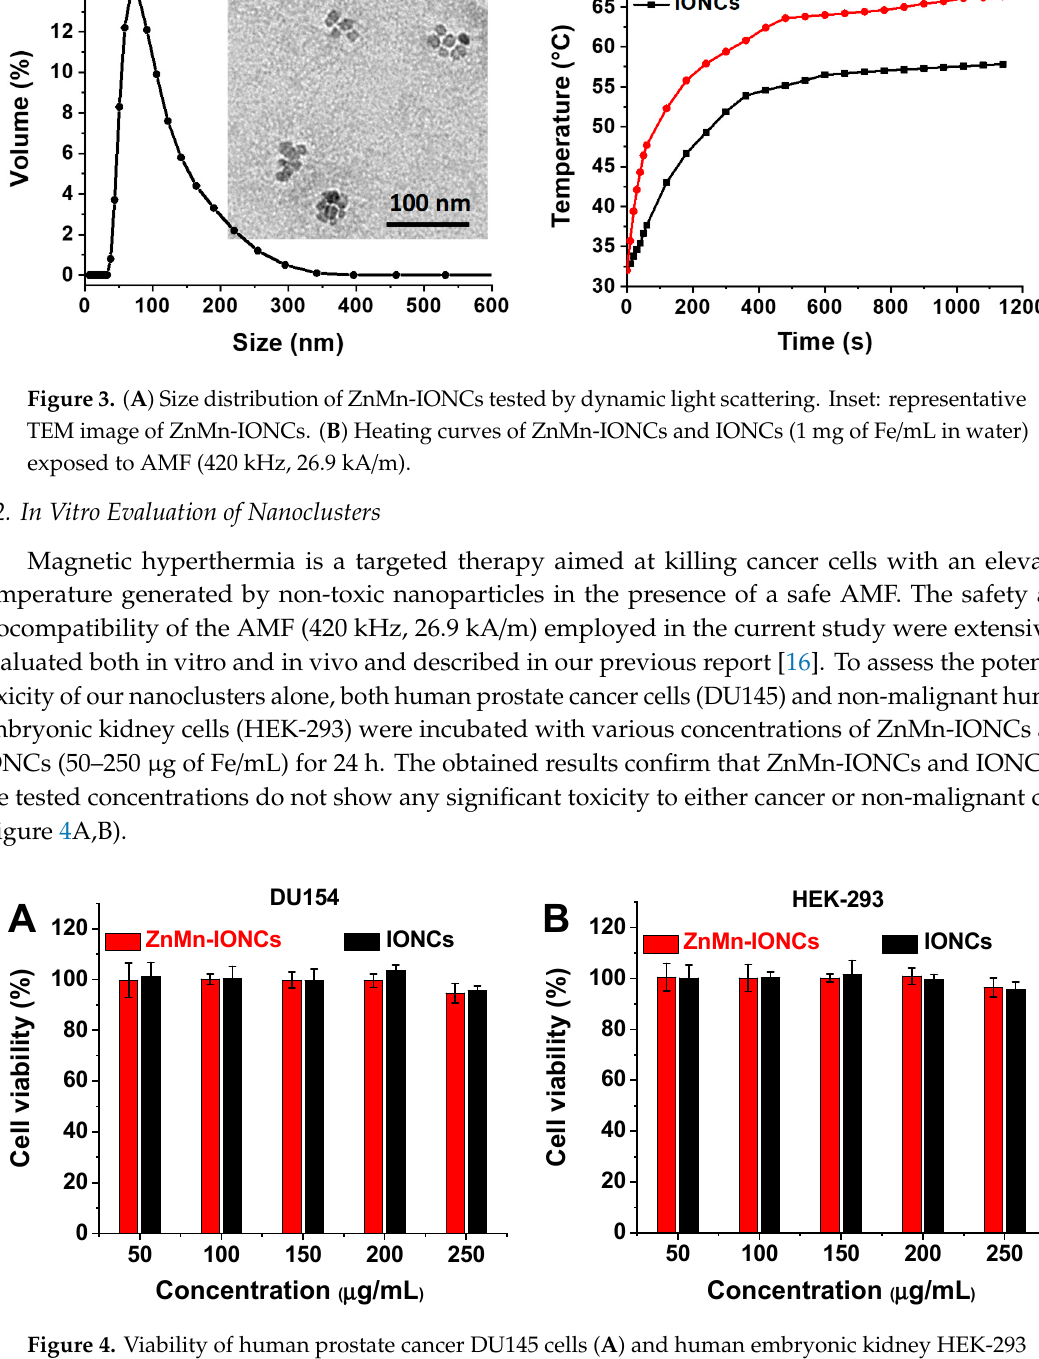
Figure 4. Viability of human prostate cancer DU145 cells ( A ) and human embryonic kidney HEK-293 cells ( B ) treated for 24 h with various concentrations of ZnMn-IONCs and IONCs (50–250 µg of Fe/mL).